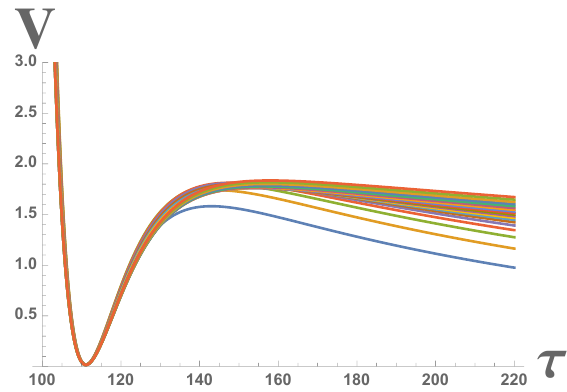
Figure 3 . The potential in the model (3.4) multiplied by 10 15 c 2 : 02 log c for t = (cid:28) + 20 log c , bc (cid:25) 1 : 5 (cid:2) 10 (cid:0) 5 and c in the broad range from c = 10 2 to c = 10 20 . and plot it as a function of (cid:28) = t (cid:0) 20 log c . We (cid:12)nd a set of dS minima for each value of c (cid:29) 1, for bc (cid:25) 1 : 5 (cid:2) 10 (cid:0) 5 . The minima of all of these potentials are at the same point (cid:28) = t (cid:0) 20 log c (cid:25) 112, with the same curvature at the minimum, and approximately the same height of the barrier, making the dS vacuum